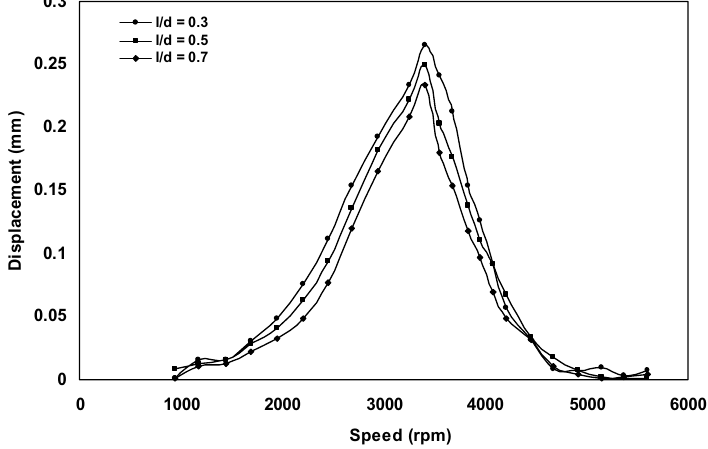
Fig. 6. L/D ratio effect on vibration amplitude (glass/epoxy damper).